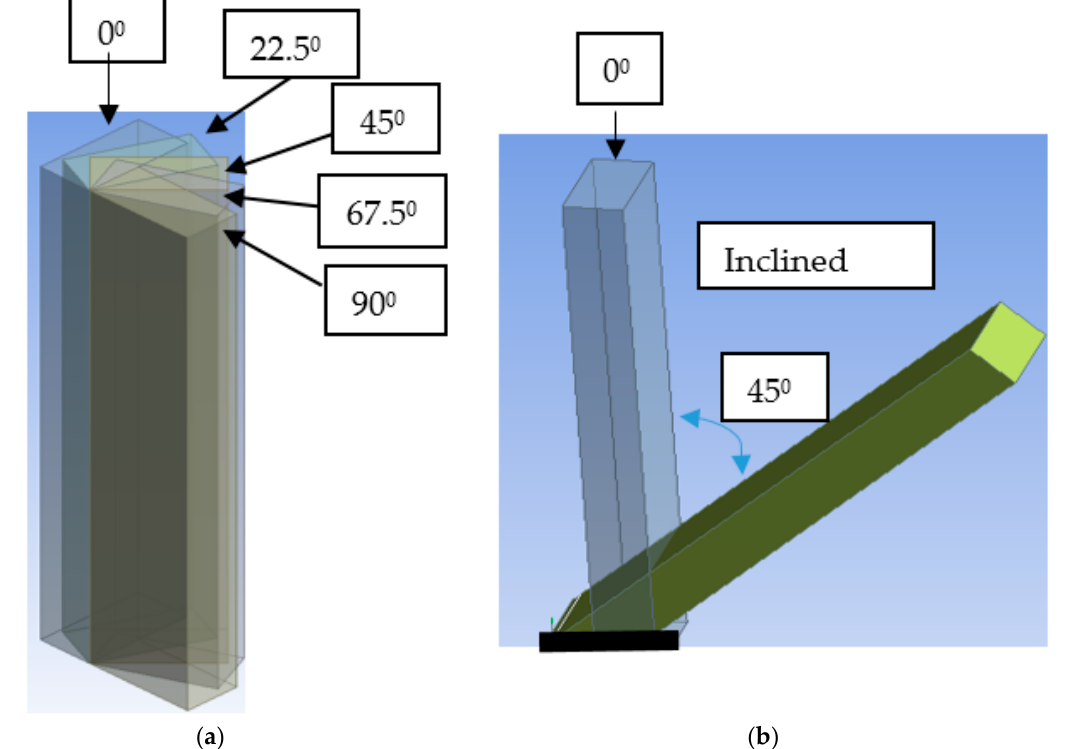
Figure 5. ( a ) Flap positioning at different clamping angles angle 0°–90°; ( b ) Inclined angle.